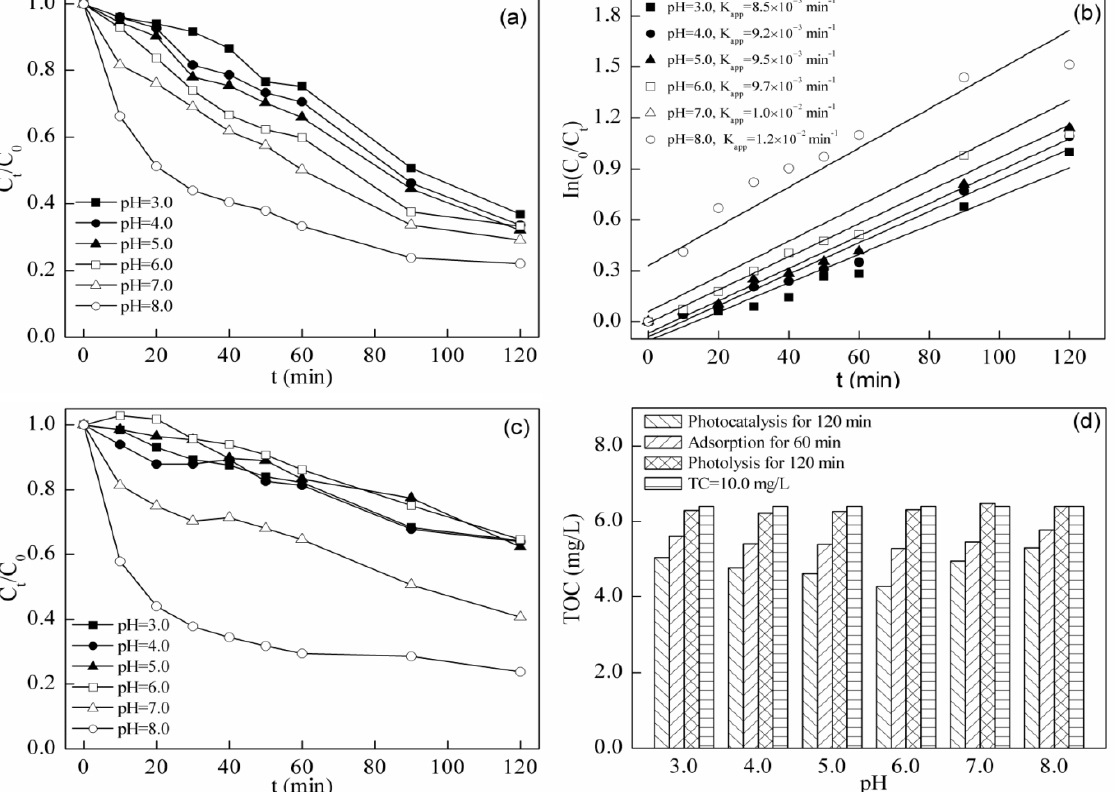
Figure 4. ( a ) Degradation and ( b ) removal kinetics of TC with BFO under visible light irradiation at different pH values; ( c ) Degradation of TC under visible light irradiation without BFO at different pH values; ( d ) Residual TOC after photolysis, adsorption and photolysis (initial TC concentration = 10.0 mg/L, initial BFO concentration = 0.5 g/L).